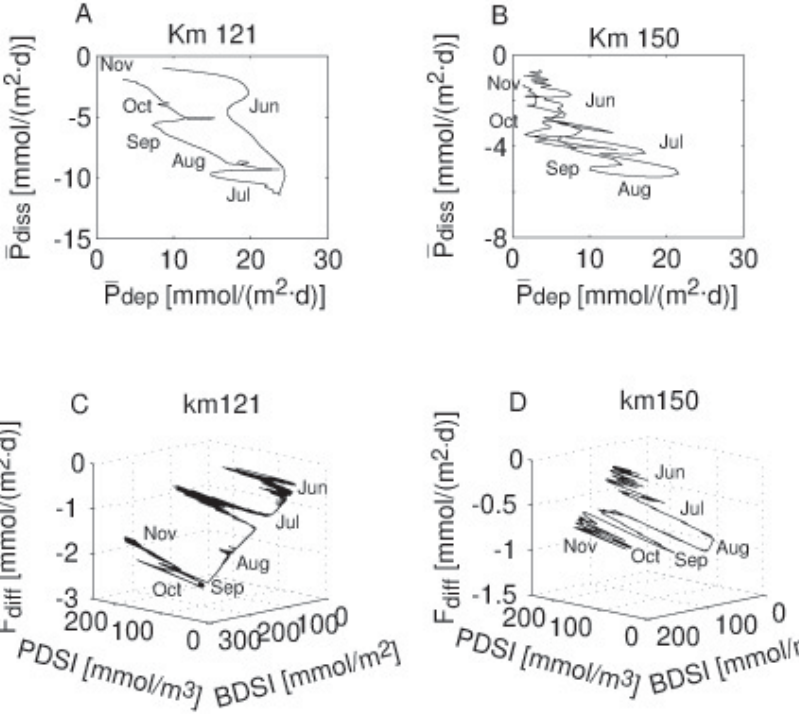
Fig. 9. Distribution of the depth-integrated silica dissolution rate P diss over the deposition flux P dep at (A) km121 (B) km150. Distribution of the diffusive silica flux F diff over the pelagic dissolved silica concentration PDSI and the depth-integrated benthic biogenic silica content BBSI at (C) km121 and (D) km150. Simulation results correspond to the simulated period (01/06/2003–30/11/2003) and the system scale parameter set(Table